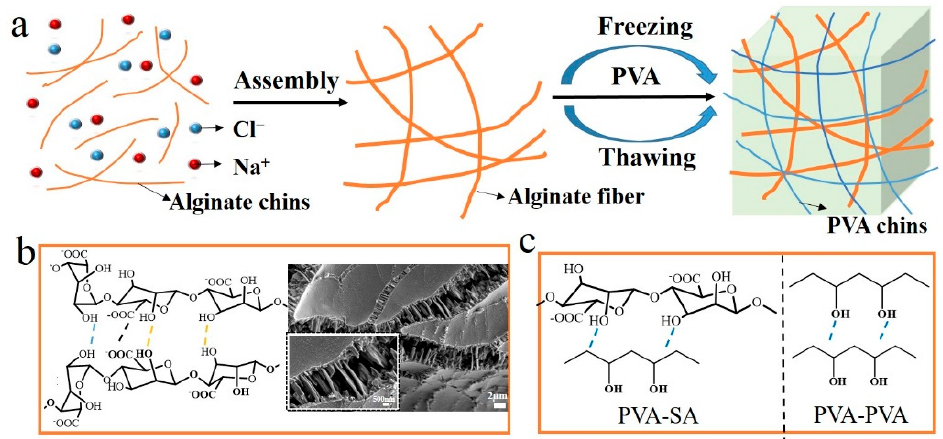
Figure 1. ( a ) The preparation process of alginate fiber-enhanced poly (vinyl alcohol) hydrogels. ( b ) The formation of alginate fibers and the SEM images; the alginate fiber solution was dropped on the silicon wafer for SEM observation. ( c ) Multiple hydrogen bonds between PVA molecules and alginate fibers.